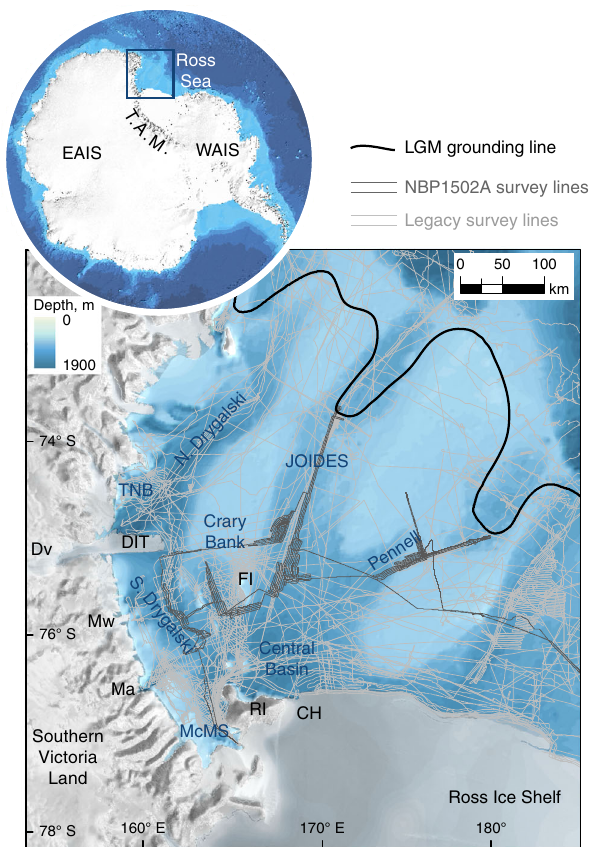
Fig. 1 The western Ross Sea. Multibeam data were compiled from NBP cruises 1994 – 2015, Oden cruises 2007 – 2010 and Araon cruises 2013 – 2015. LGM grounding line from ref. 12 . Bathymetry and inset panel image from IBCSO 76 . TNB = Terra Nova Bay, Dv = David Glacier, DIT = Drygalski Ice Tongue, Mw = Mawson Glacier, Ma = Mackay Glacier, McMS = McMurdo Sound, RI = Ross Island, FI = Franklin Island, CH = Coulman High, T.A.M. = Transantarctic Mountains, EAIS = East Antarctic Ice Sheet, WAIS = West Antarctic Ice